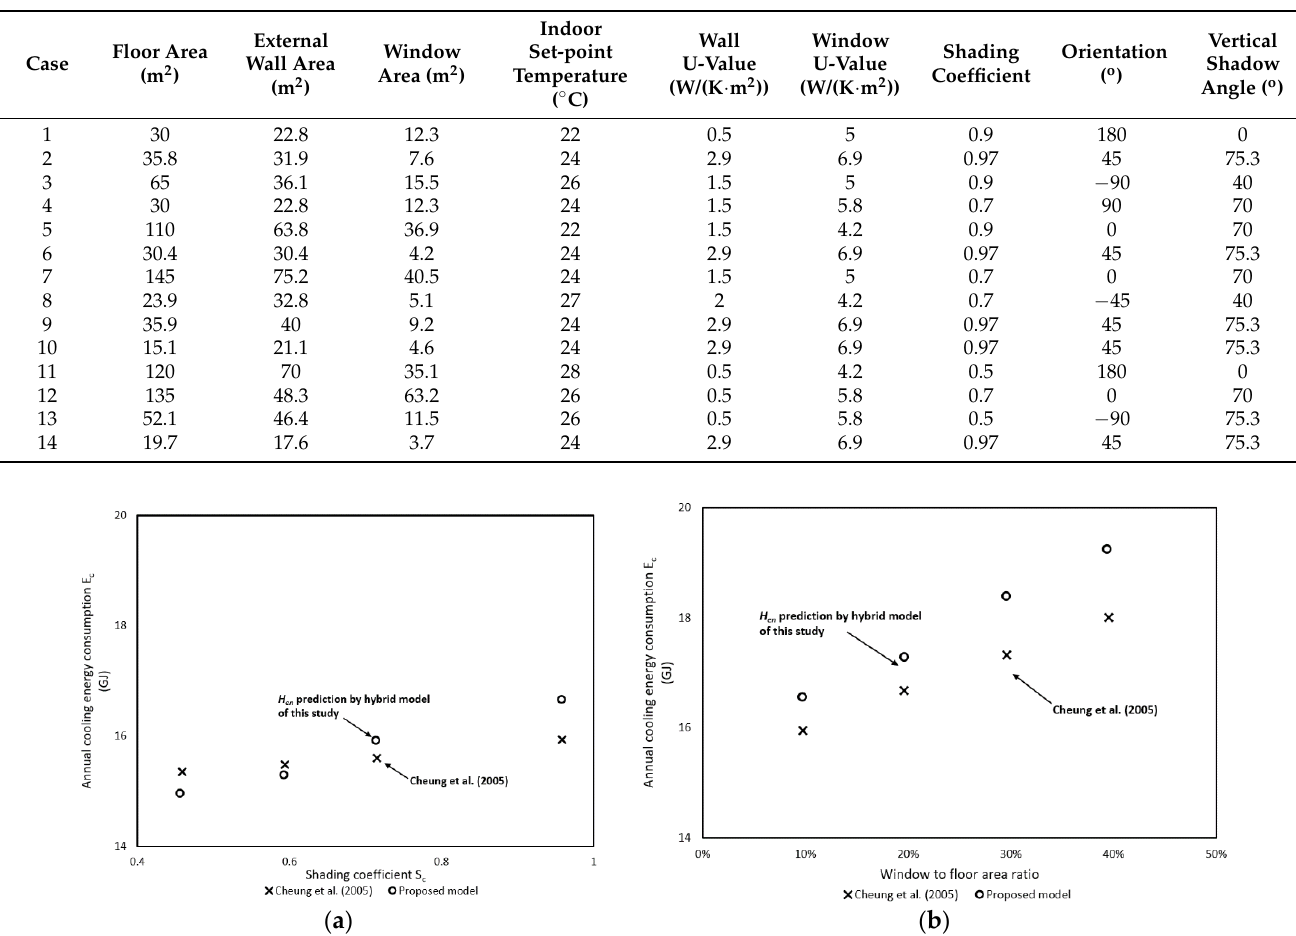
Table 2. Apartment details and other parameters for model validation.